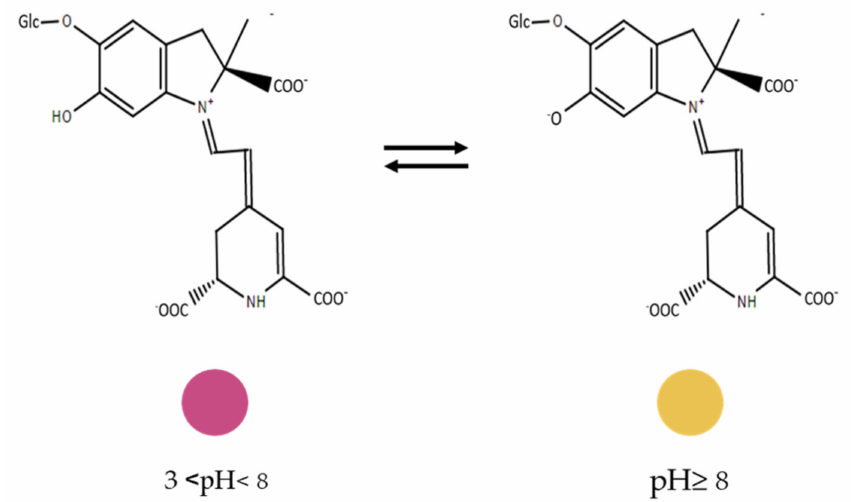
Figure 3. Changes in betalains structure due to pH changes, adapted from